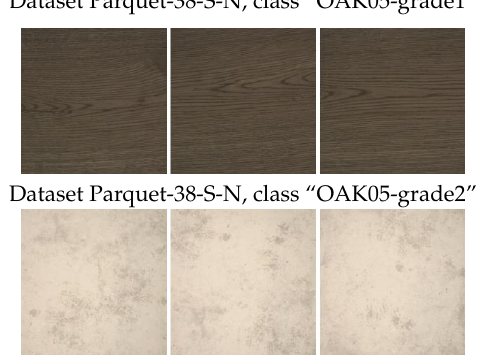
Figure 14. Hand-crafted image descriptors proved generally better than CNN-based features for the classification of stationary textures acquired under invariable imaging conditions. The gap was substantial when it came to discriminating between very similar textures, as those shown in the picture.